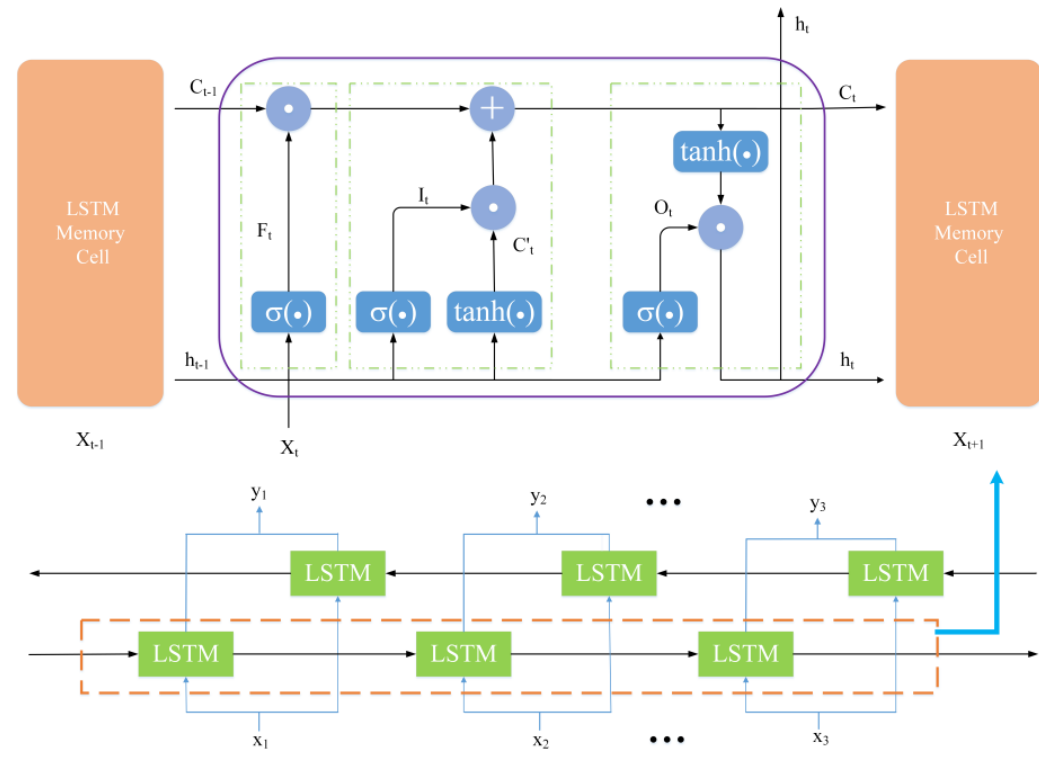
Figure 2. The internal structure of the BiLSTM unit.